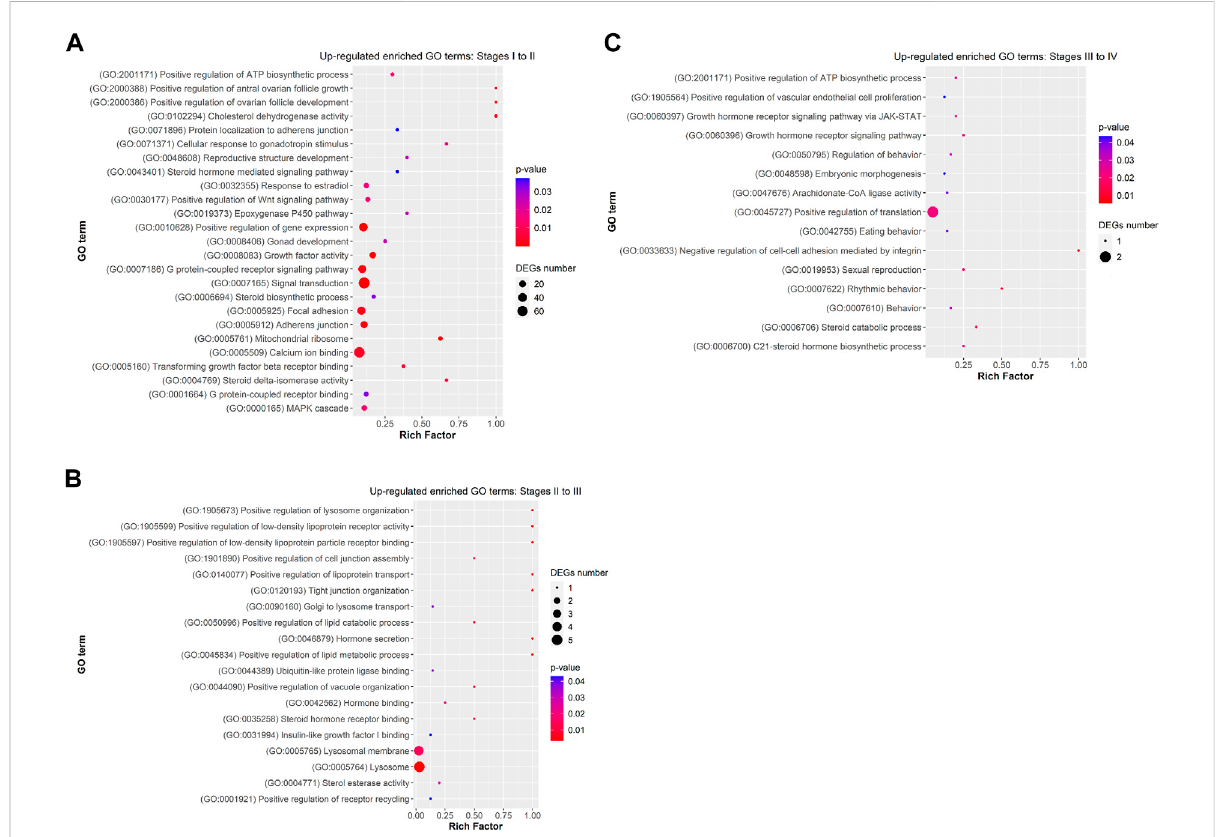
FIGURE 5 Dotplotshowingsomerelevantsigni fi cantlyenrichedGeneOntologybiologicalprocesses,cellularcomponentsandmolecularfunctionsfrom upregulated DEGs in (A) Stage I to II (B) Stage II to III, and (C) Stage III to IV. Rich factor is the ratio of the differentially expressed gene number to the total gene number in a certain GO term. The colour and size of the dots represent the range of the p -value and the number of DEGs mapped to the indicated GO term,